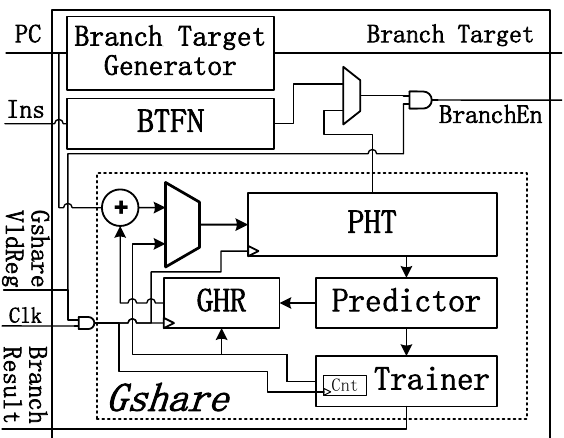
Figure 7. Variable branch predictor.